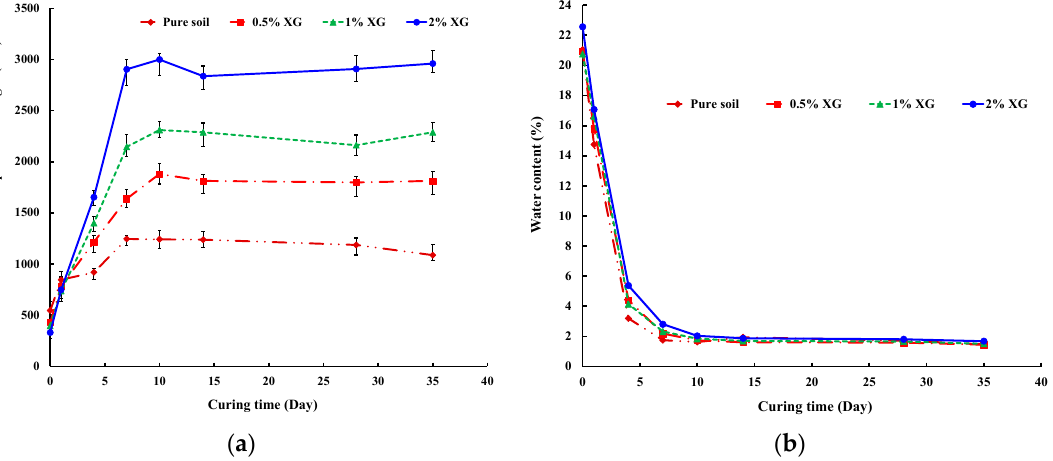
Figure 2. ( a ) Variation of UCS for the XG-treated soil with curing time; ( b ) changes in water content with curing time.